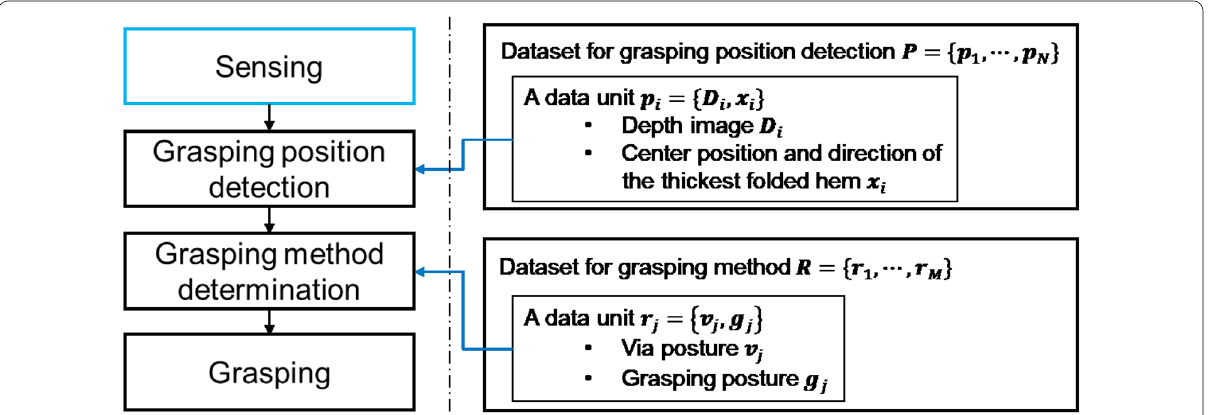
Fig. 2 The basic procedure and structured data for grasping a folded cloth